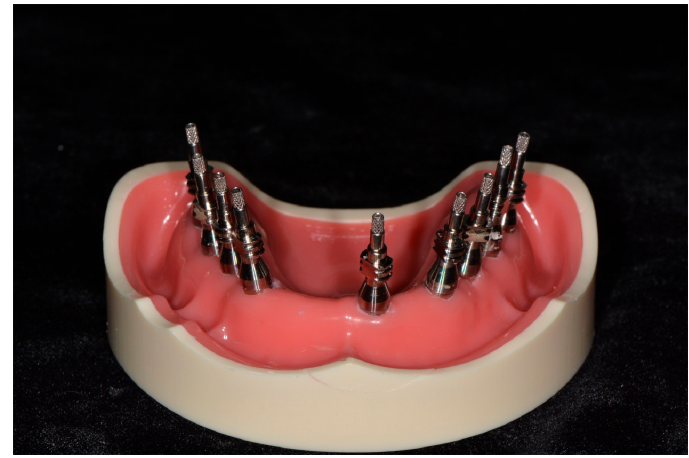
Figure 2. Connected impression copings.